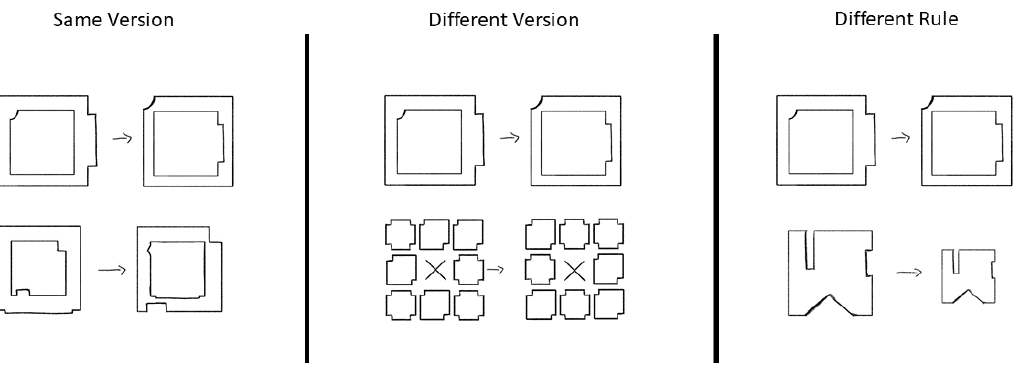
Figure 3. RSJT comparison stimuli example. Note. The same version comparison example includes two swap rules, the different version comparison includes two slightly different swap rules, and the different rule comparison includes a swap rule and a size change rule.